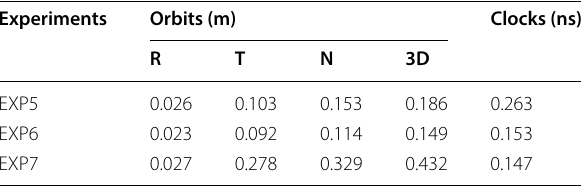
Table 4 Accuracies for orbits and clocks obtained by different OD and TS schemes under the condition of single one‑way Ka‑pseudoranges